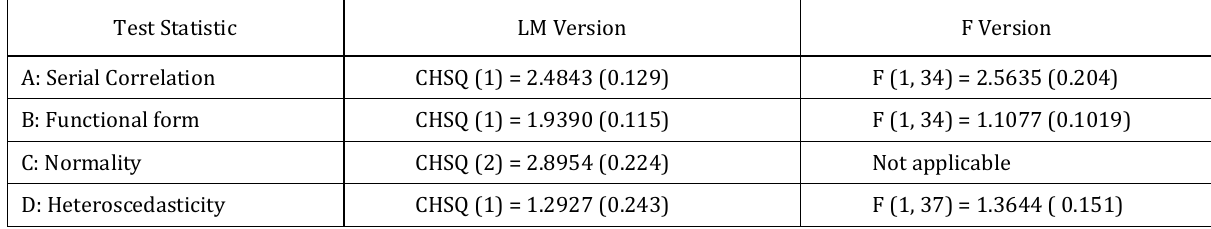
Table A2. Results of ARDL Diagnostic tests (source: author’s estimations)